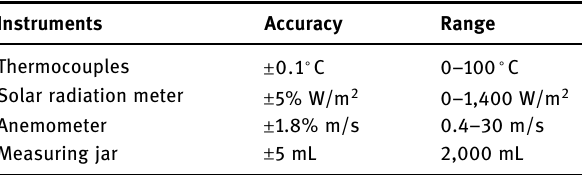
Table 2: Accuracy and range for the measuring instruments Instruments